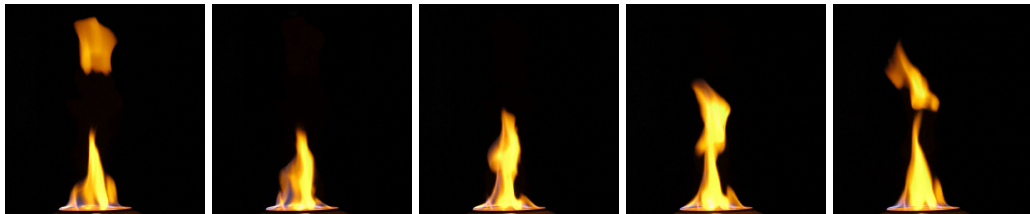
Figure 18. Consecutive flame frames from one camera.